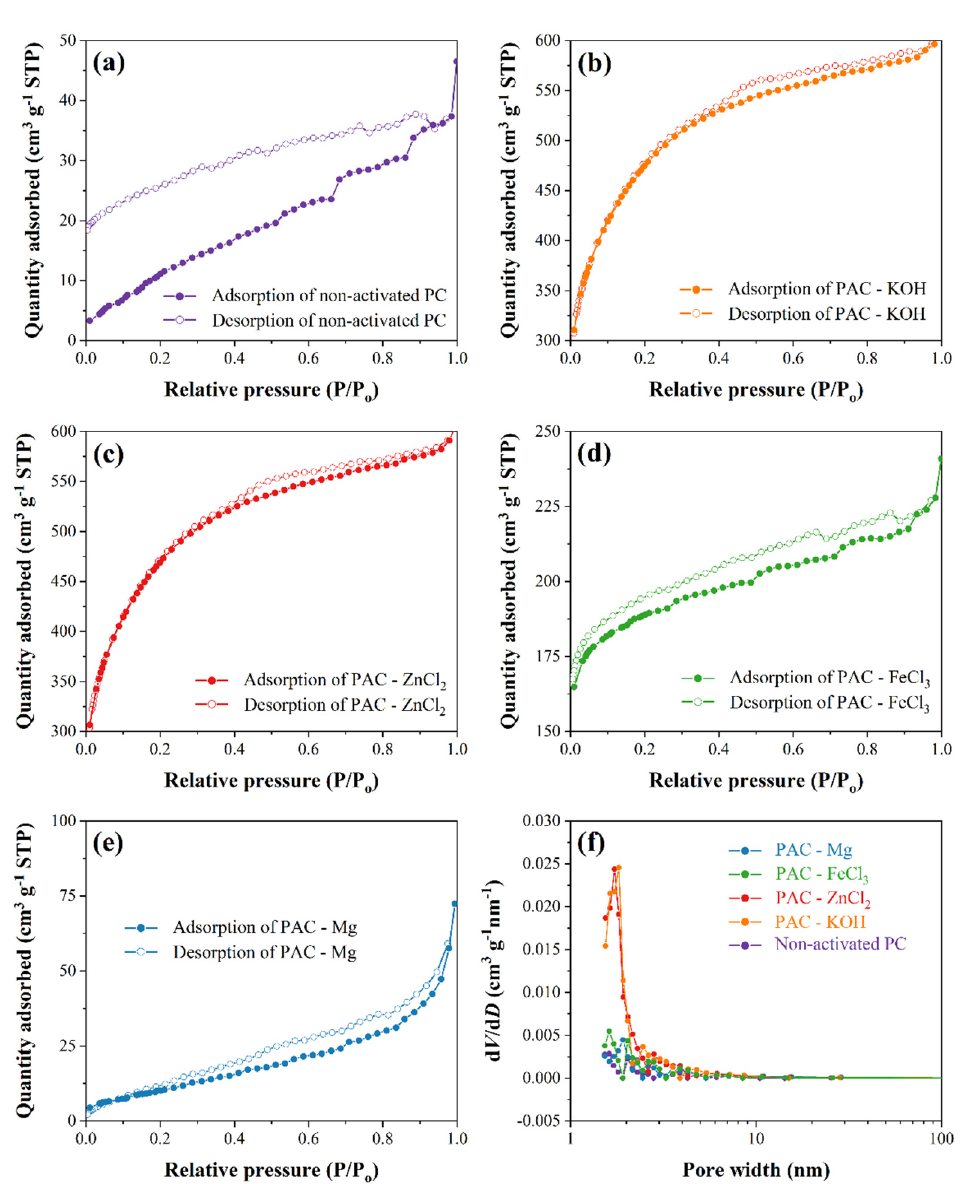
Figure 3. N 2 adsorption–desorption isotherm of ( a ) non-activated PC and PAC electrodes using different activating agents of ( b ) KOH, ( c ) ZnCl 2 , ( d ) FeCl 3 , and ( e ) Mg. ( f ) Pore size distribution of all samples calculated with the BJH model.